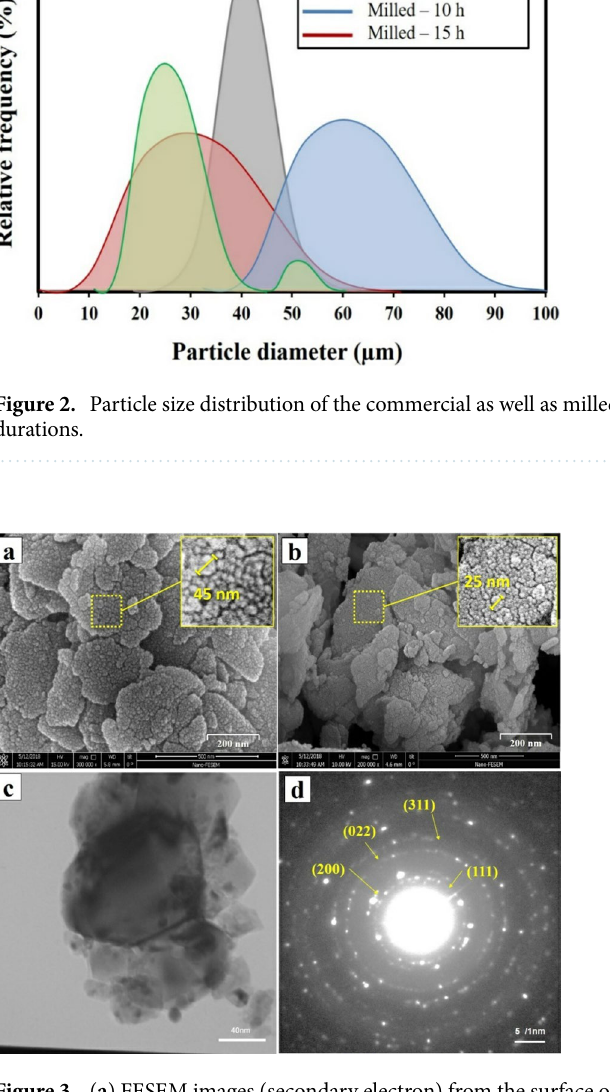
Figure 3. ( a ) FESEM images (secondary electron) from the surface of the nanocrystalline powder after 10 and ( b ) 15 h of ball-milling process, ( c ) TEM bright-field image of a nanocrystalline powder particle developed after 15 h of the milling process, and ( d ) corresponding SAD pattern represented nanocrystalline Ni-based γ phase in the milled powder